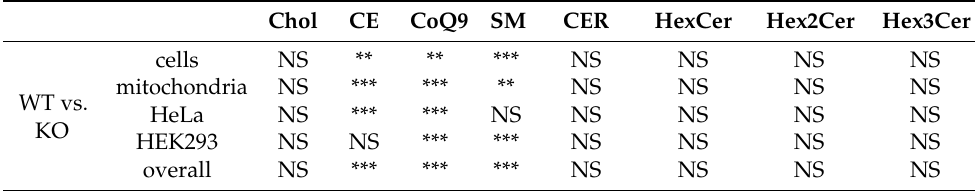
Table 1. Statistical analysis of lipidomics data from